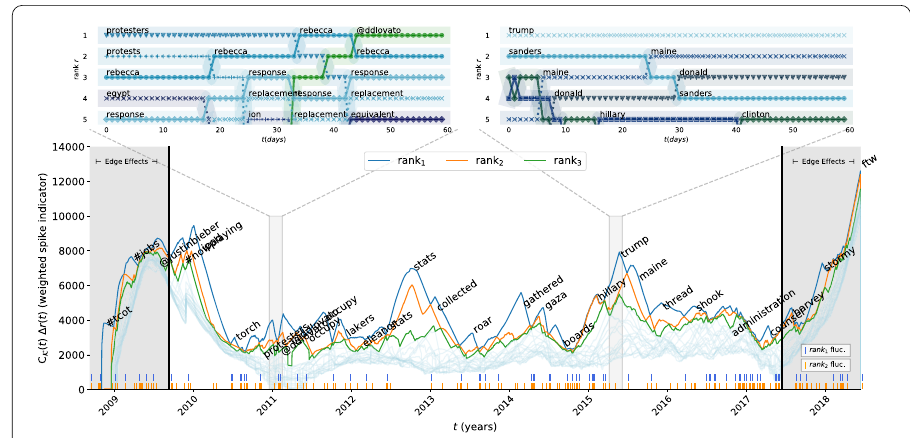
Figure 12 Spike leaderboard. Time series of the ranked and weighted spike indicator function. At each time step t , the weighted spike indicator functions (WSpIF) are sorted so that the word with the highest WSpIF corresponds to the top time series, the words with the second-highest WSpIF corresponds to the second time series, and so on. Vertical ticks along the bottom mark fluctuations in the word occupying ranks 1 and 2 of WSpIF values. Top panels present the ranks of WSpIF values for words in the top 5 WSpIF values in a given time step for the sub-sampled period of 60 days. The top left panel, demonstrates the competition for